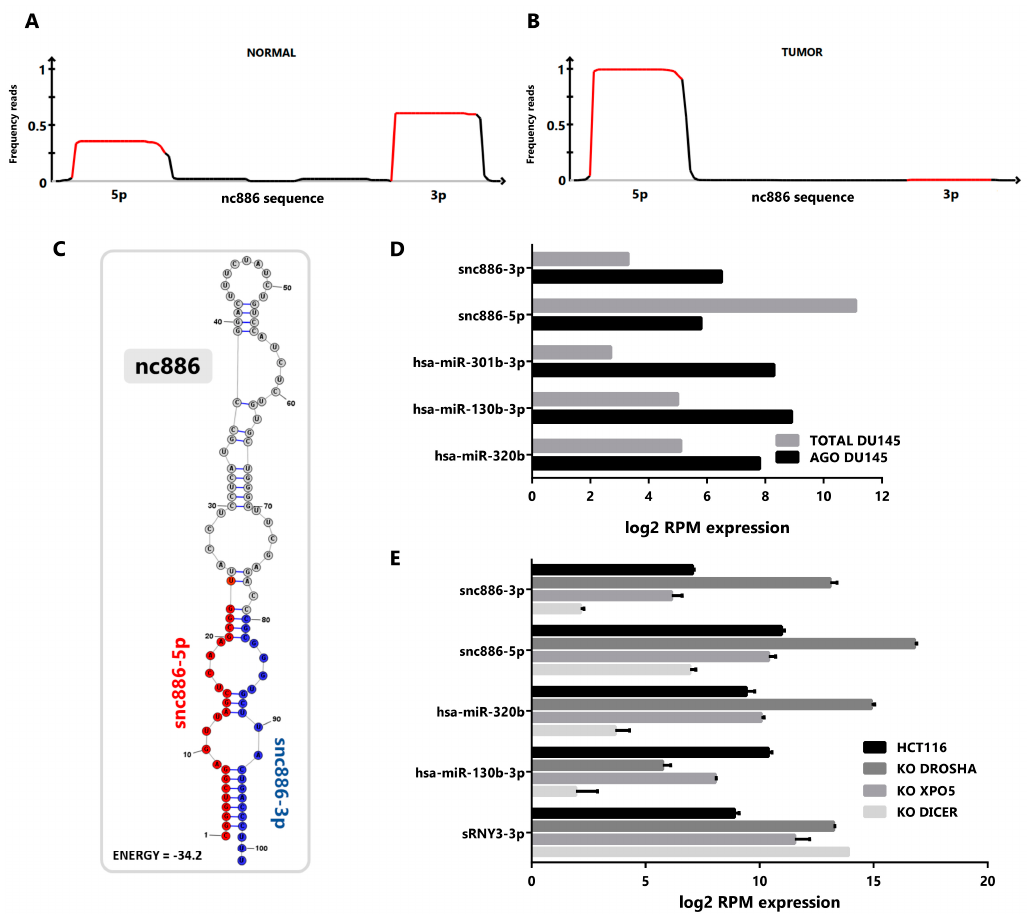
Figure 1. nc886 derived fragments are produced in prostate cell lines and exhibit microRNA features. ( A , B ) Mapping of prostate cell small RNA reads along the sequence of nc886. Reads obtained from small-RNA transcriptomes of non-transformed prostate PrEc and PrSC (GEO id: GSE26970) ( A ) and tumor DU145, PC-3 and LNCaP cell lines (SRA id: SRP109305 and GEO id: GSE66035) ( B ) were mapped to nc886. A diagram of nc886 (Refseq (NR_030583.2)), plus additional 10 nt at both ends, is depicted below the plots. Red lines in the plots represent the previously annotated hsa-miR-886-3p and -5p. ( C ) Predicted secondary structure of nc886 (Refseq (NR_030583.2)) based on maximum free energy (MFE) generated with the RNAstructure software [44]. ( D ) Association of small RNAs to Argonaute in transcriptomic analysis of DU145 cell line. The graph shows the normalized expression, reads per million (RPM), of small non-coding RNAs in total cellular RNA (TOTAL DU145) and in the Argonaute PAR-CLIP fraction (AGO DU145). Data set available at SRA id: SRP075075. ( E ) Transcriptomic analysis of small non-coding RNAs of the HCT116 cell line with knockouts for the microRNAs biogenesis proteins DROSHA, EXPORTIN 5 and DICER. Data set available at GEO id: GSE77989. Average value and standard error are